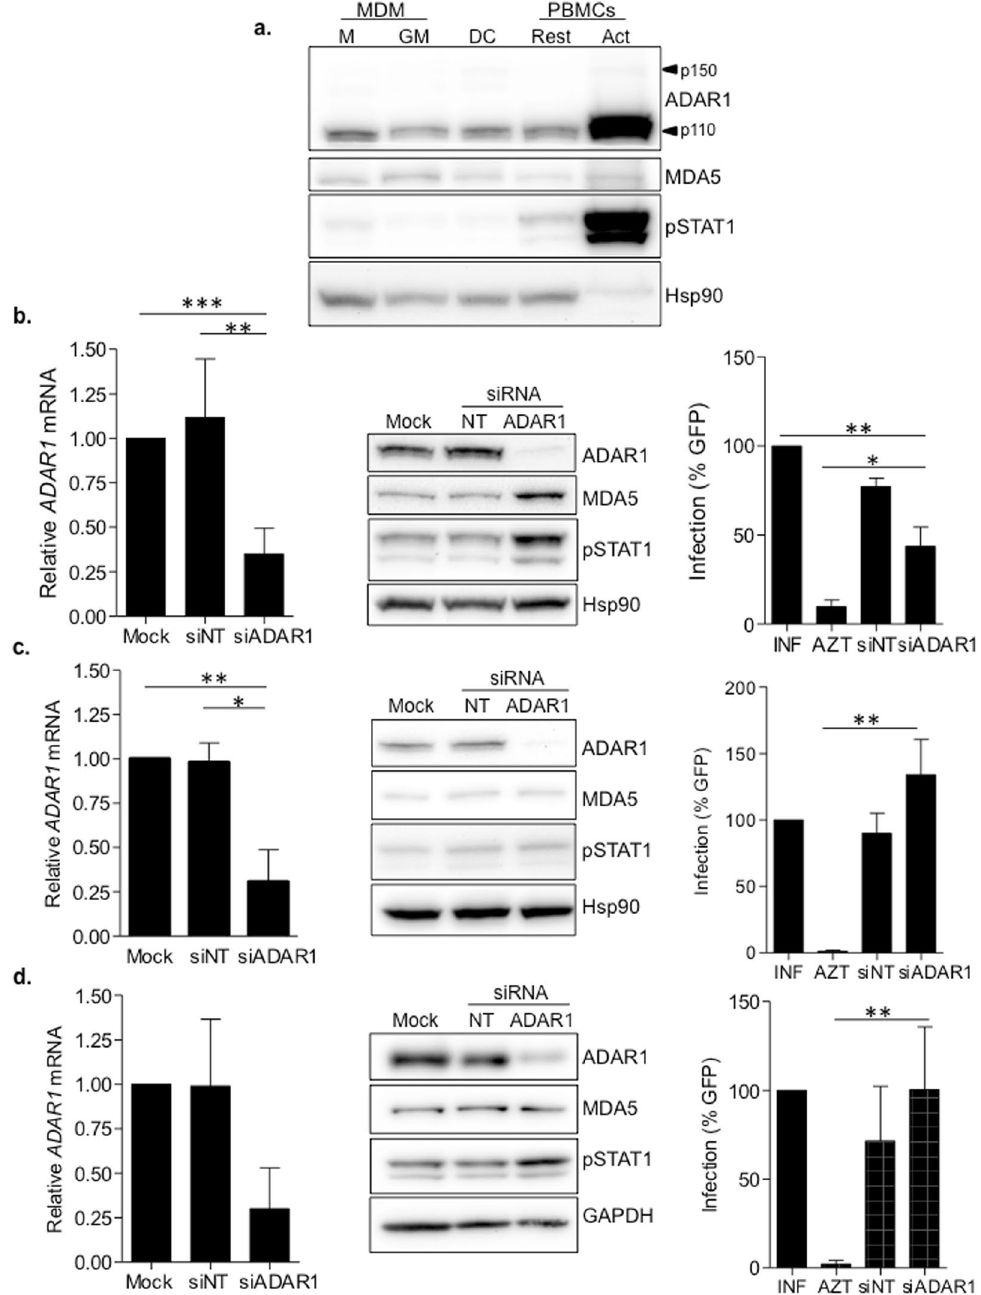
Figure 3. ADAR1-mediated regulation of innate immune activation and HIV-1 infection is specific of macrophages. ( a ) Evaluation of ADAR, MDA5 and pSTAT1 protein expression in different myeloid and lymphoid primary cells. ADAR1 and pSTAT1 expression were increased in activated PBMCs compared to other cell types. M; M-CSF macrophages, GM; GM-CSF macrophages, DC; monocyte derived dendritic cells, Rest; Resting PBMCs and Act, Activated PBMCs. Hsp90 was used as loading control. A representative experiment is shown. ( b–d ) Evaluation of ADAR1 knockdown in GM-CSF macrophages ( b ), monocyte-derived dendritic cells ( c ) and CD4 + T cells ( d ). Downregulation of ADAR1 mRNA expression by qPCR (left panels), western blot showing protein expression (middle panels) and susceptibility to HIV-1 infection (right panels) are shown. Effective ADAR1 mRNA inhibition was achieved in all cell types (B-D, left panels). Upregulation of MDA5 and pSTAT1 was only observed in ADAR1 knockdown GM-CSF macrophages ( b , middle panel), which correlated with inhibition of HIV-1 replication (B, right panel). No significant differences were observed in protein expression or HIV-1 infection in dendritic cells or CD4 + T cells, following ADAR1 knockdown (C and D, middle and right panels respectively). Data from mRNA expression and HIV-1 infection represent the mean ± SD of 3 different donors. A representative western blot is shown in each case. The figure shows the cropped gels/blots obtained by each protein evaluation. Full-length blots of each tested protein are included in supplementary material. * p < 0.05; ** p <